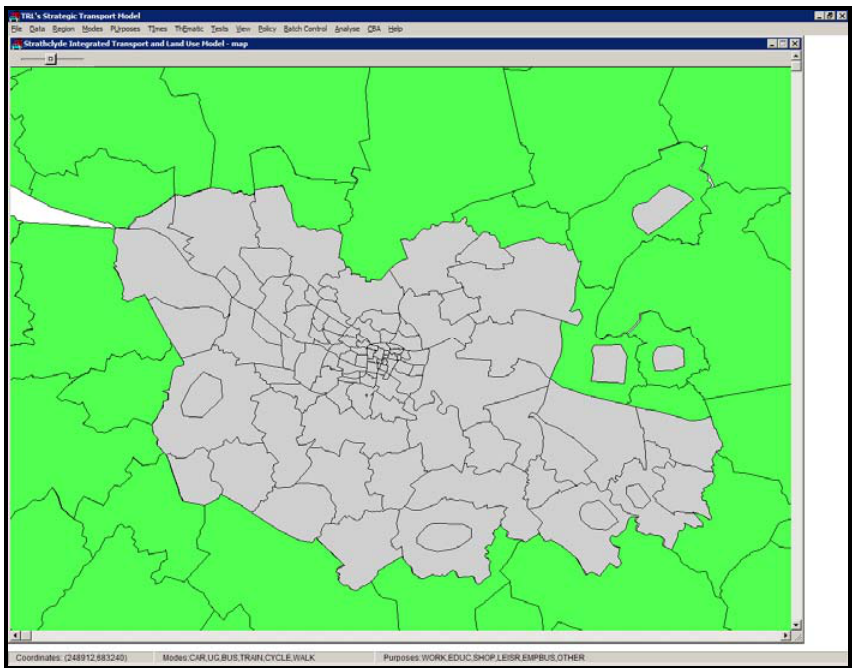
Figure 7. The Graphical User Interface of the 233 zone STM (the large grey area is the Glasgow